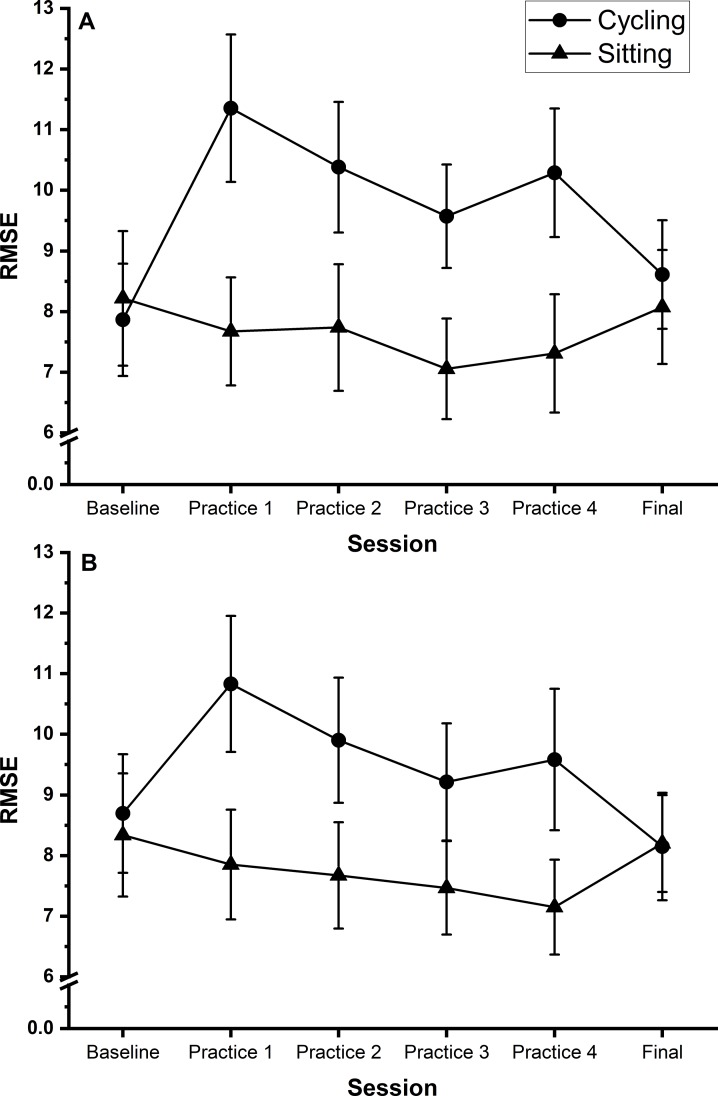
Tracking.Shows line graphs of average root mean square error (RMSE) during the tracking subtest across all sessions. Graph A (top) = no guide; Graph B = with guide. Circles represent the cycling group, triangles the sitting group. Smaller RMSE values indicate greater accuracy. Error bars represent standard error of the mean.